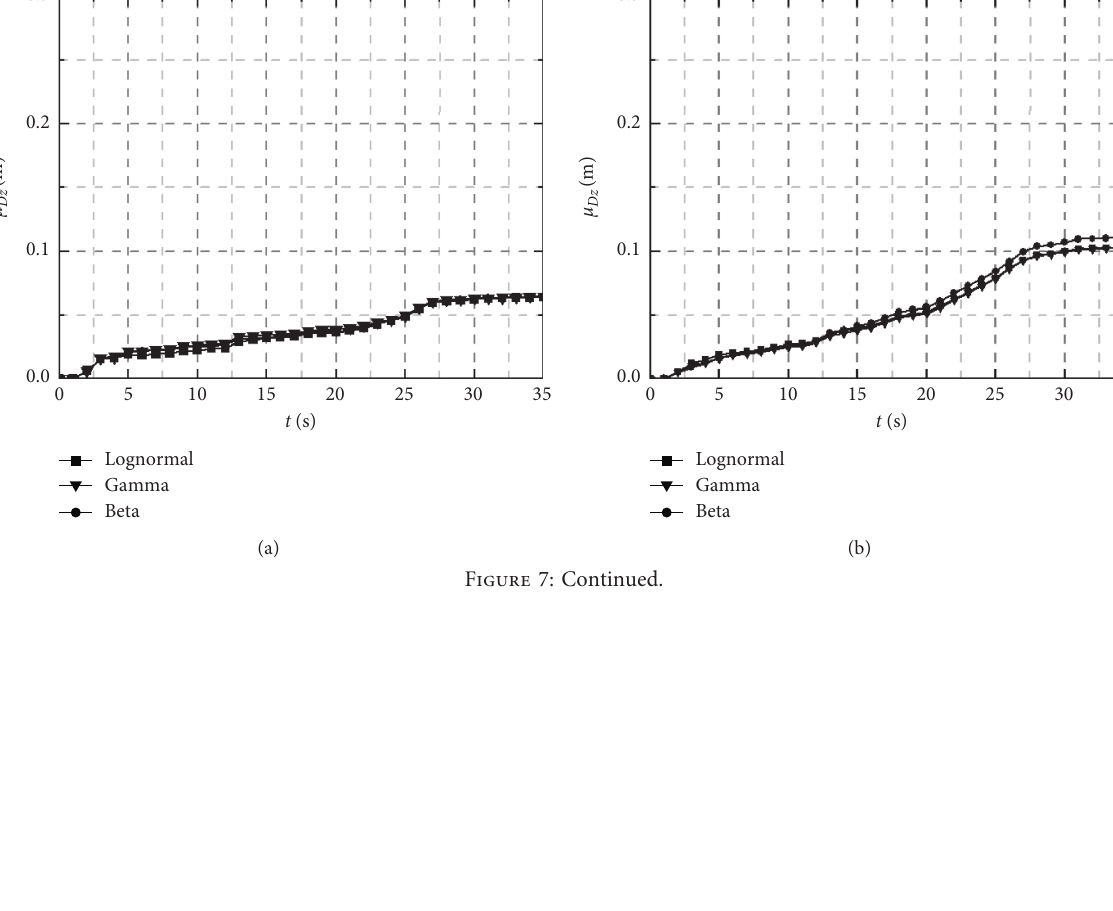
D x, max as a function of CoV G : (a) δ x